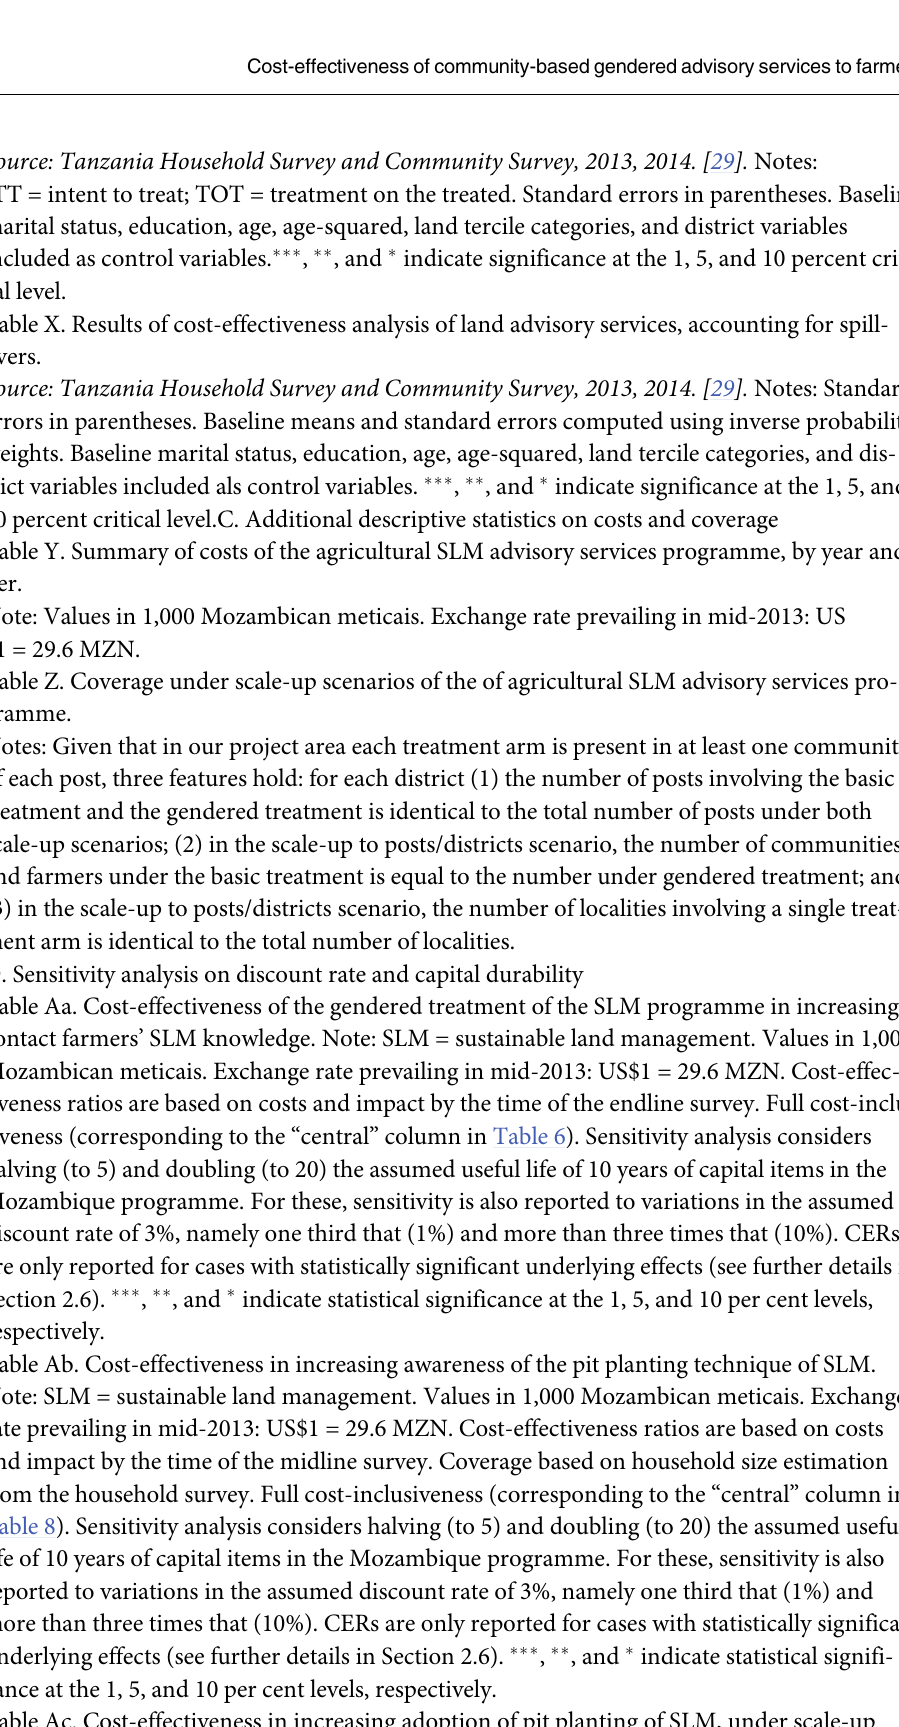
Table Ac. Cost-effectiveness in increasing adoption of pit planting of SLM, under